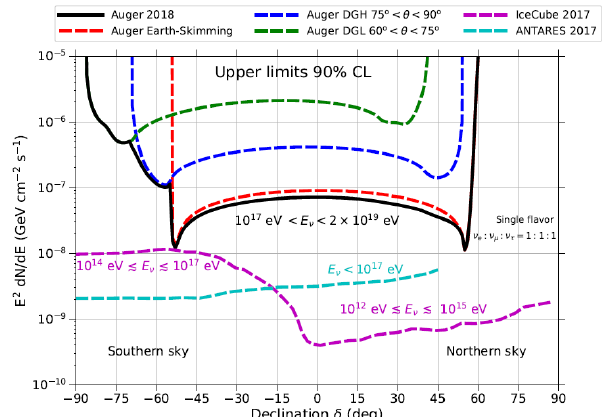
Figure 5. Upper limits on the neutrino flux normalization from steady sources [15]. Limits are calculated for a point source at given declination and single flavour